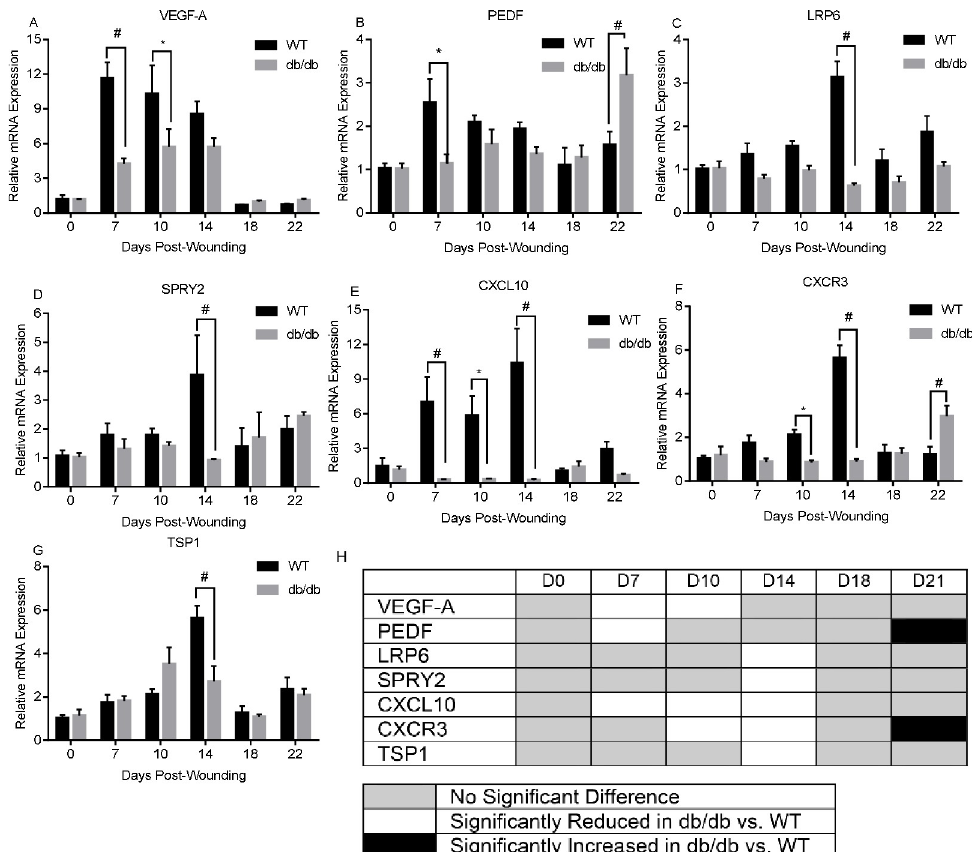
Fig 3. A-G) Semi-quantitative RT-PCR analysis of pro- and anti-angiogenic factors over the time course of wound healing. n = 5, � p < 0.05, #p < 0.01. H) Heatmap summarizing findings of A-G, showing genes with no difference (gray boxes)significant downregulation (white boxes) or upregulation (black boxes) over the time course of healing in db/db versus WT mice. In the figure, factors are identified using common protein name abbreviations; for gene symbols